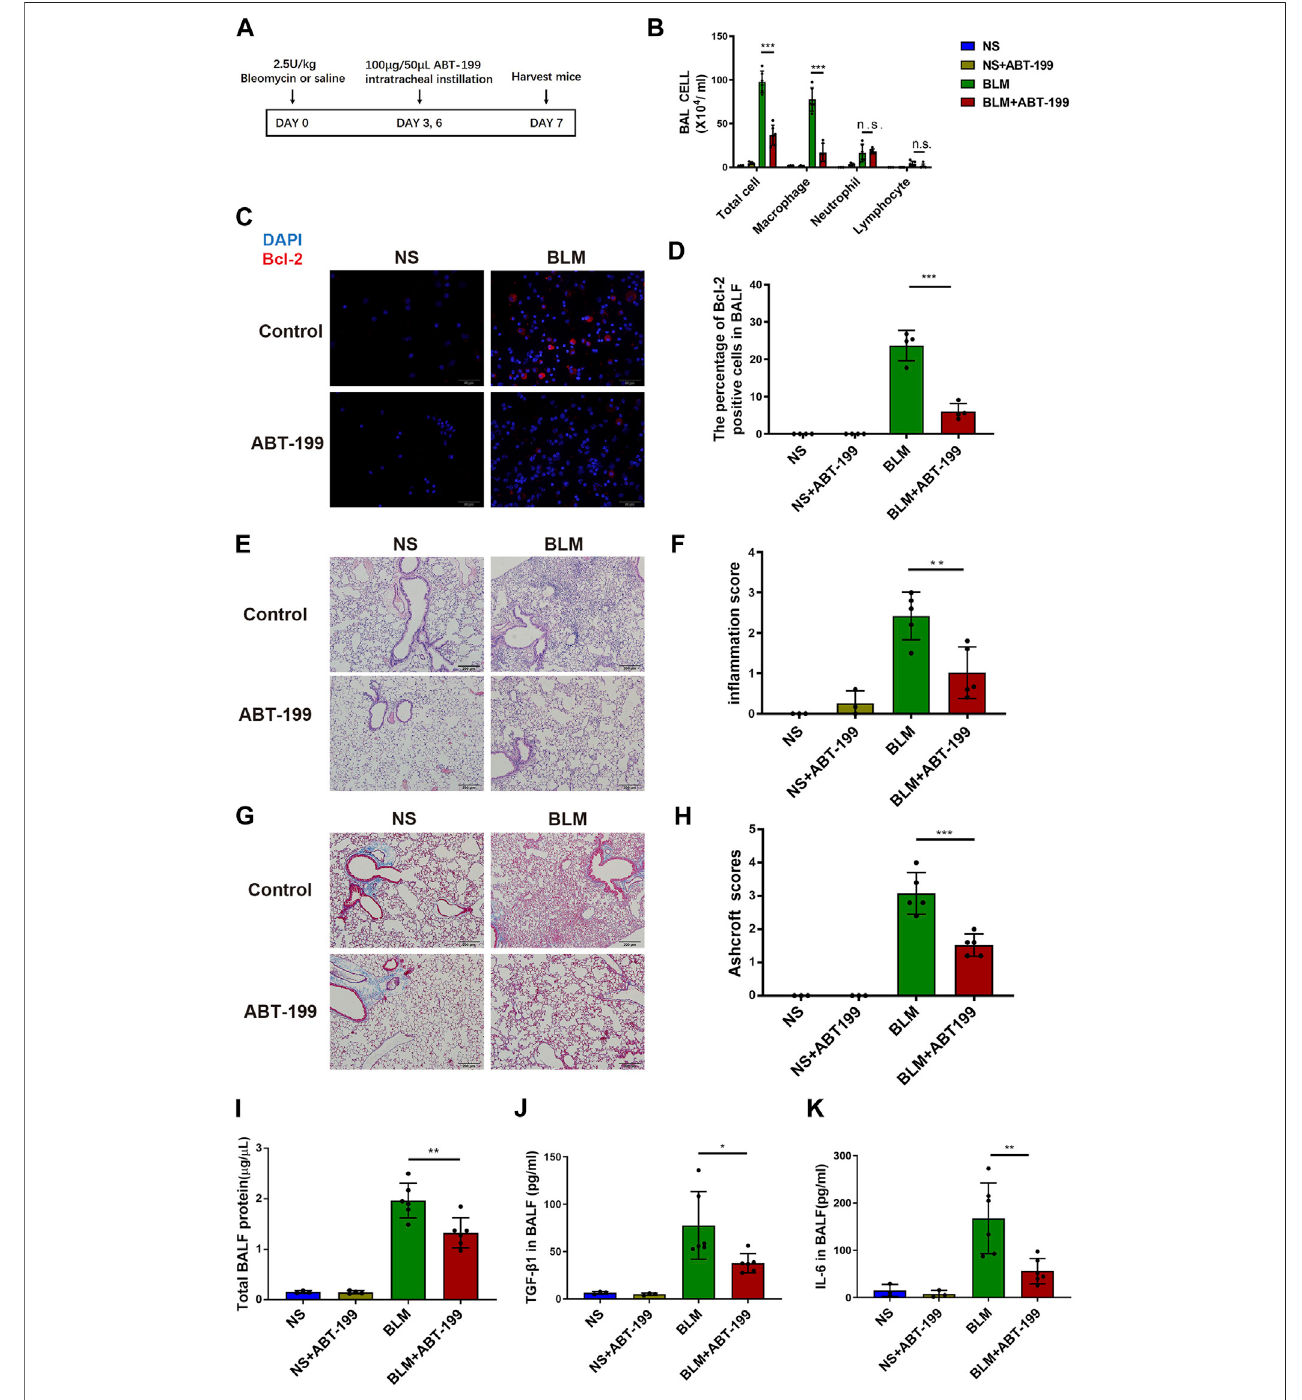
FIGURE 2 | Early ABT-199 treatment attenuated BLM-induced lung in fl ammation at day 7. (A) Treatment scheme. (B) After 7 days, the total number of in fl ammatory cells was quanti fi ed and the number of differential cells was calculated. (C) Intracellular Bcl-2 expression of BAL cells was assessed by immuno fl uorescence assay on day 7. (D) The percentage of Bcl-2 positive macrophages was determined. (E) Representative images of lung sections stained with hematoxylin and eosin (H&E). (F) Degree of parenchymal alveolitis was evaluated using Szapiel score. (G) Representative images of lung sections stained with Masson ’ strichrome. (H) Theareaanalysisof fi broticchangesaccordingtoAshcroftscale. (I) TotalBALFproteinonday7wasmeasuredusingBCAProteinAssay. (J , K) Expressions ofTGF- β 1 and IL-6 levels in BALF on day 7 were determined using ELISA. The data are presented asmeans ± SD of an experiment performed three times. n.s., not signi fi cant, * p < 0.05, ** p < 0.01, *** p < 0.001. n (cid:2) 3 – 6. BLM, bleomycin; BAL, bronchial alveolar lavage; NS, normal saline; Bcl-2, B-cell lymphoma-2.